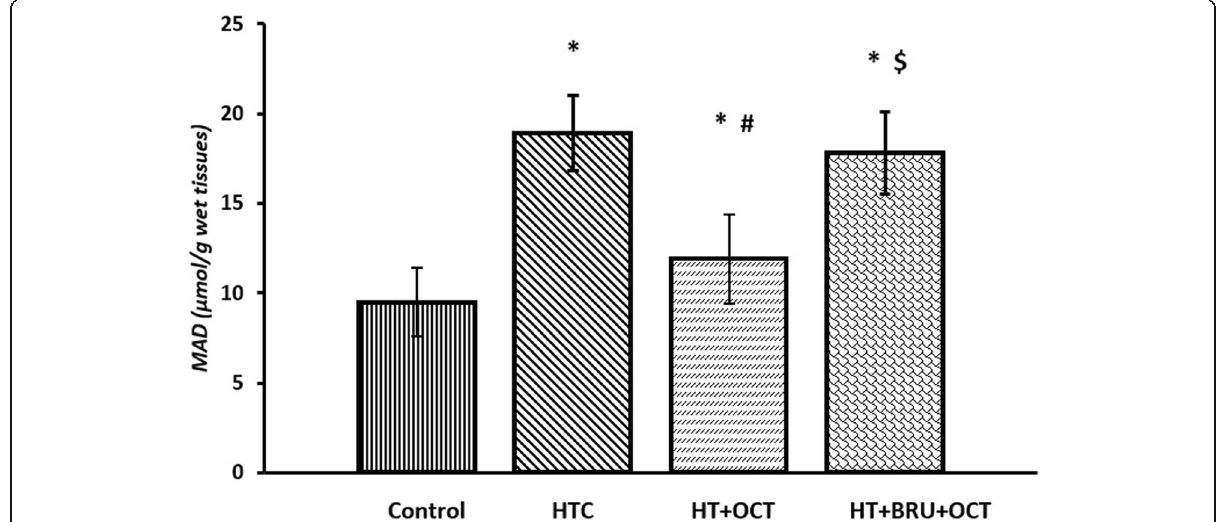
Fig. 4 Effect of octreotide on cardiac tissue MDA in rat hearts exposed to ischemia for 30 min and reperfusion for 120 min. n = 10 rats in each group. Data are represented as mean ± standard deviation. Significance ( P < 0.05): *significant when compared with the control group, # significant when compared with HTC group, $ significant when compared with HT+OCT